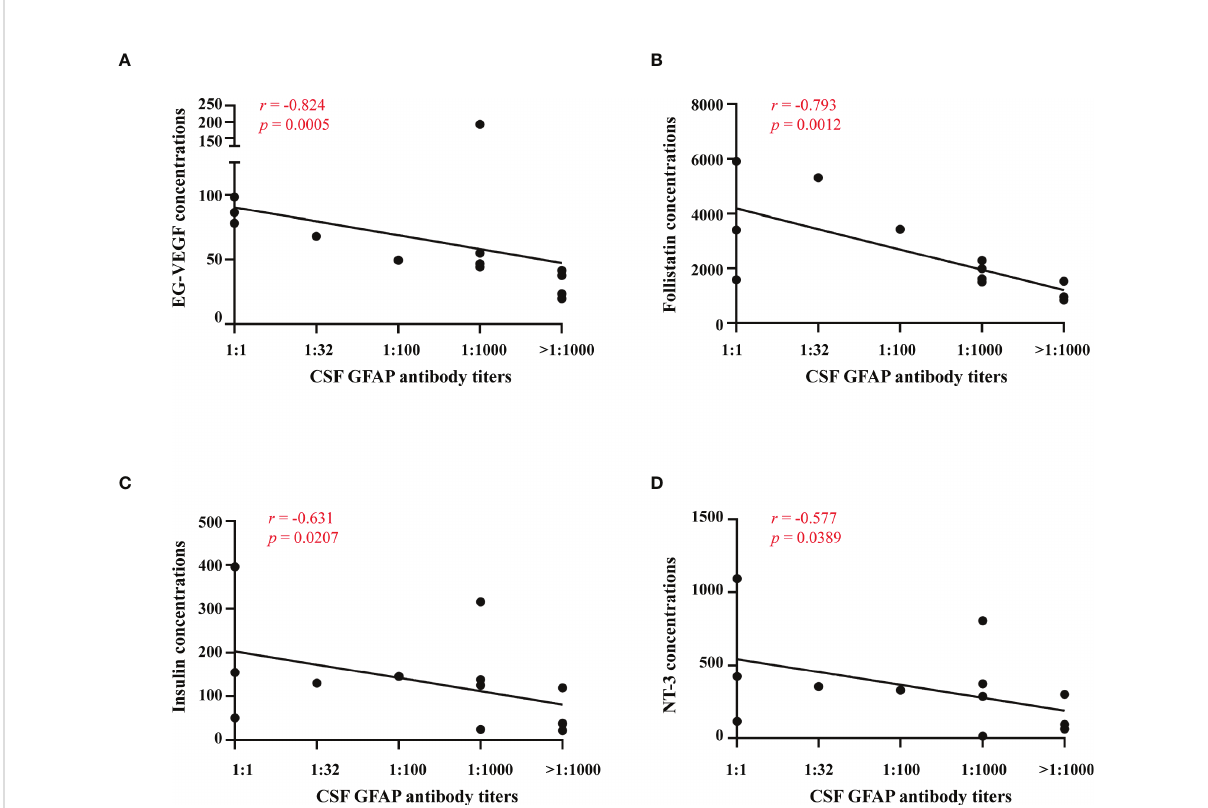
FIGURE 5 Relationships between serum cytokines and anti-GFAP antibody titers. Correlations between anti-GFAP antibody titer and serum levels of EG- VEGF, follistatin, insulin and NT-3 were analyzed by spearman ’ s rank analysis and were showed in (A –